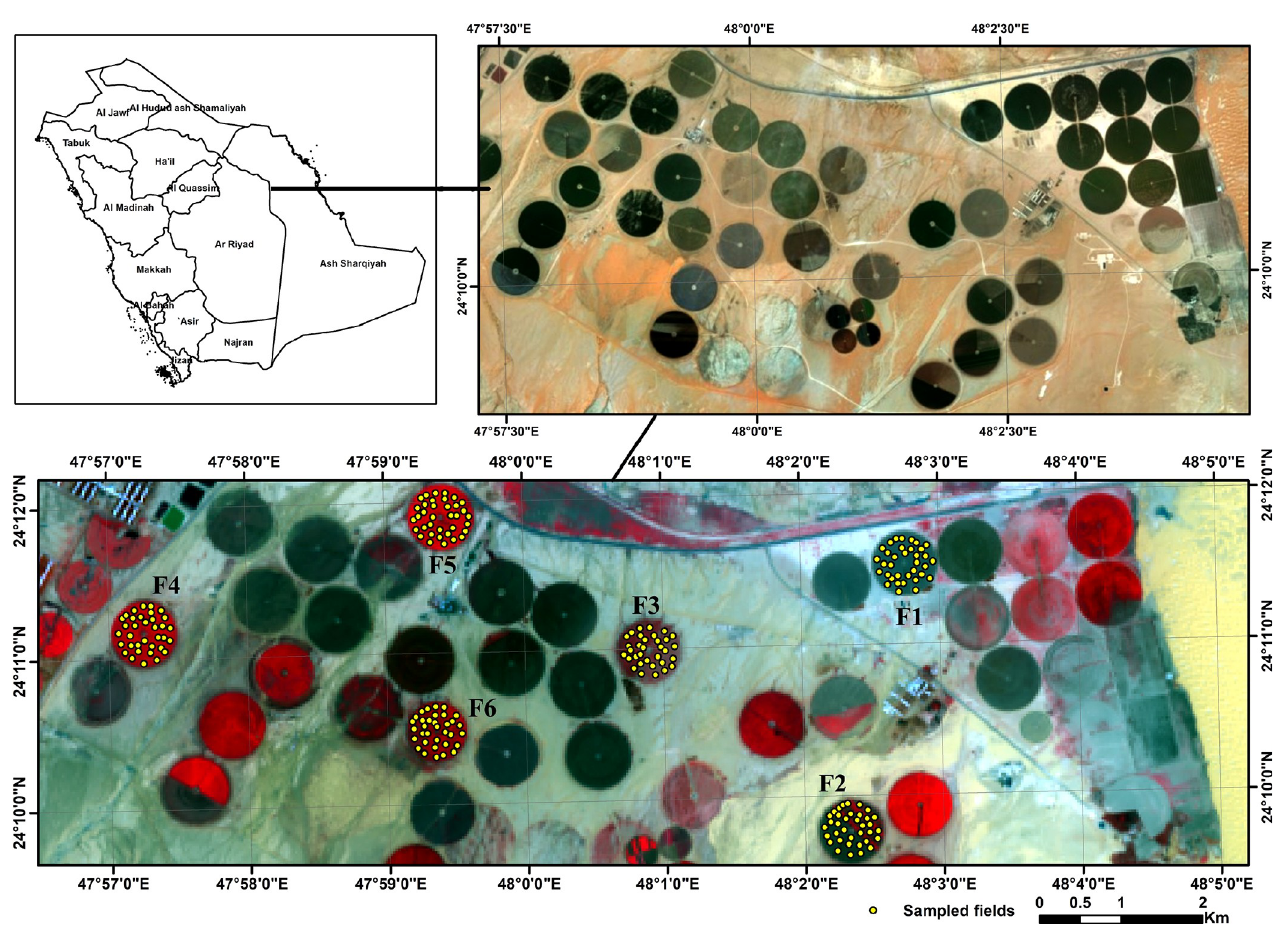
Fig 1. Location map of the experimental fields overlaid by the sampling